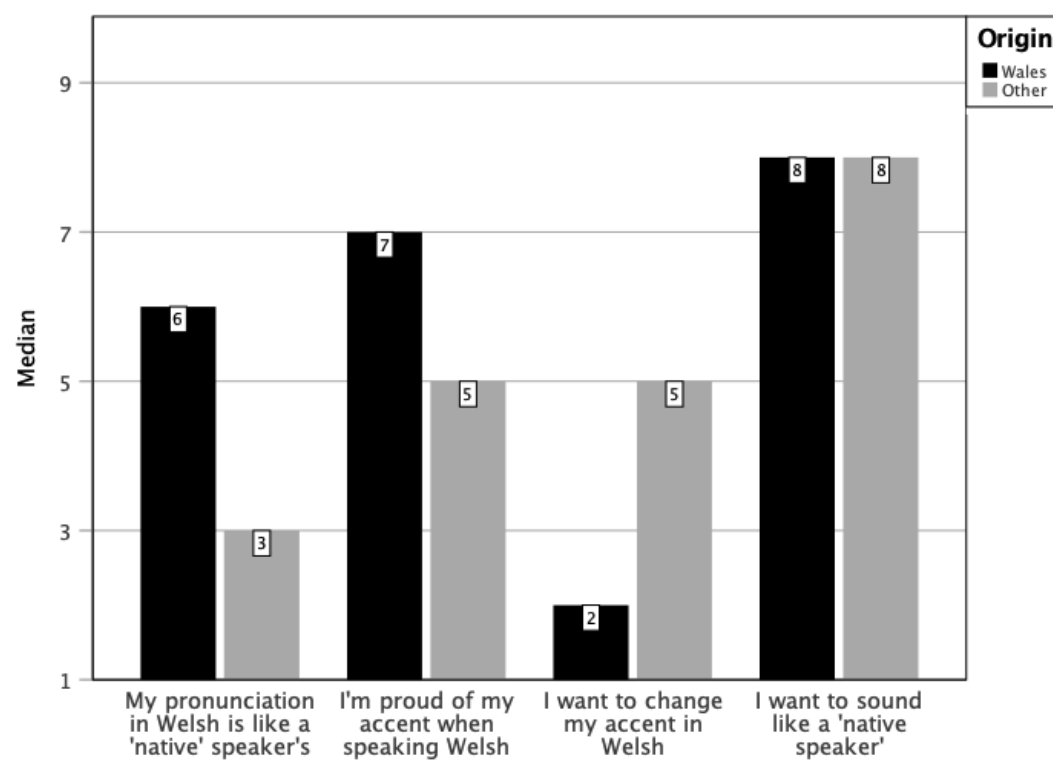
Figure 2. Median scores for statements on accent and pronunciation for speakers from Wales, and from outside of Wales (1 = Not at all, 9 = Completely).